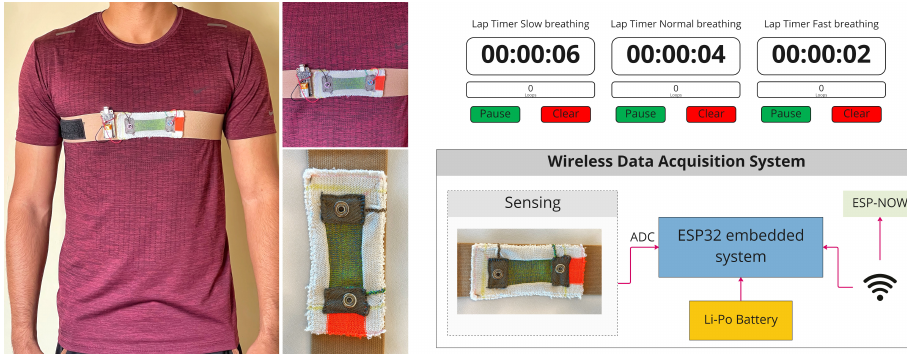
Figure 16. Human testing and data acquisition system.